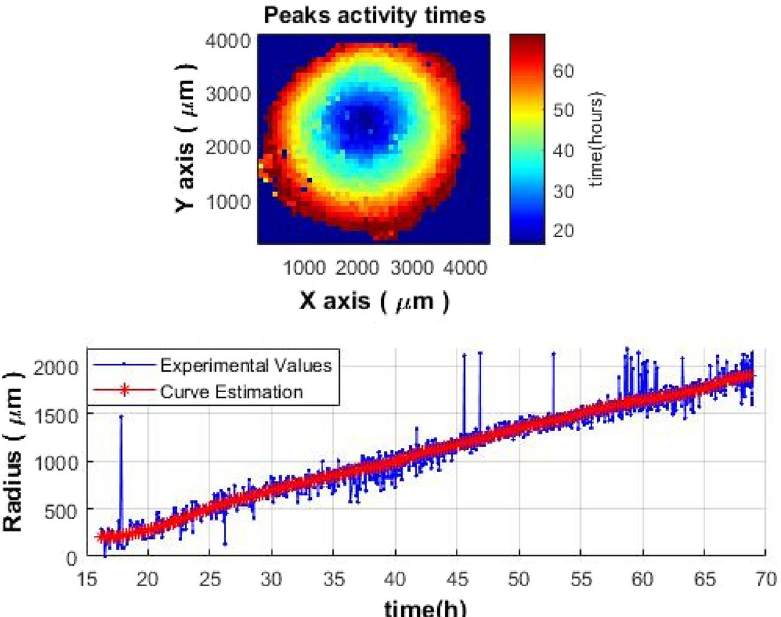
Figure 6. The time of colony peak activity (the start of the decrease in activity) during the growth of S. aureus colony. Top image—a two-dimensional spatiotemporal image; bottom image—the peak activity as a function of time. Similar spatiotemporal behavior of the signal was observed also within colonies of E. coli and V.